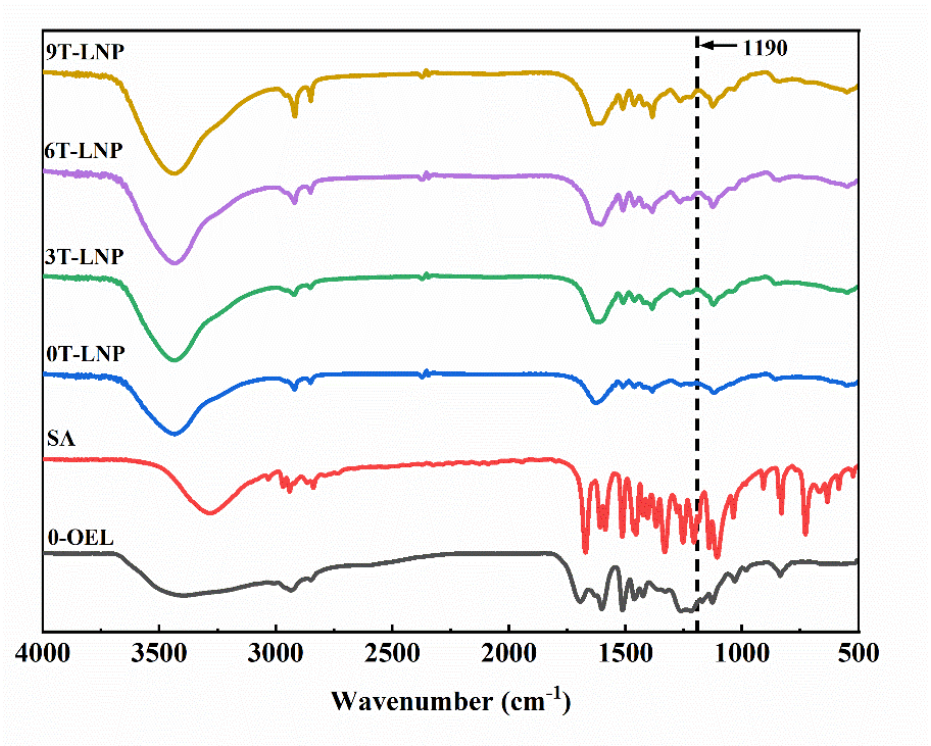
Figure 5. FT − IR spectra of 0 − OEL, SA, and T − LNPs.